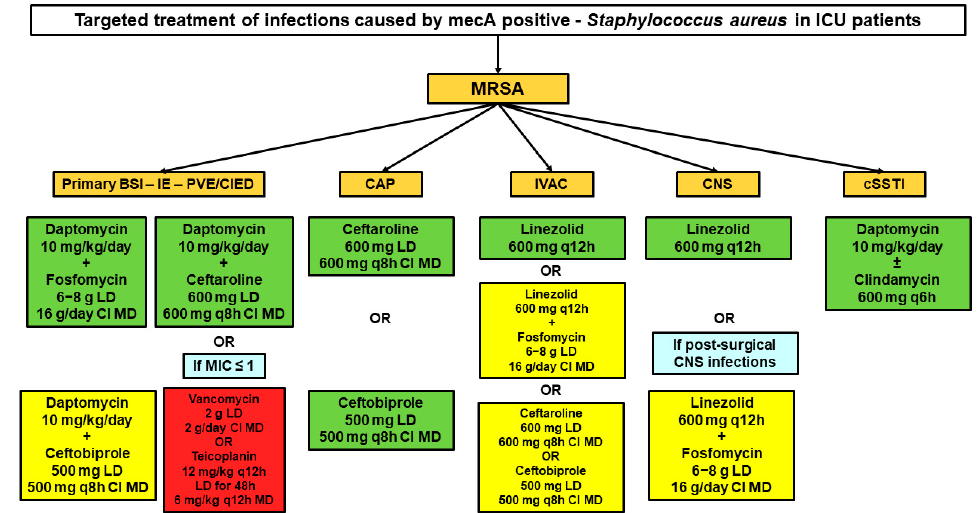
Figure 2. Algorithms for targeted therapy of BSIs or IE caused by methicillin-resistant Staphylococcus aureus . Green box: best therapeutic regimen according to current evidence; yellow box: alternative therapeutic regimen according to current evidence; red box: therapeutic regimen recommended only in specific situations. BSI: bloodstream infection; CAP: community-acquired pneumonia; CI: continuous infusion; CIED: cardiac implantable electronic device infections; CNS: central nervous system; cSSTI: complicated skin and soft tissue infection; ICU: intensive care unit; IE: infective endocarditis; IVAC: infective ventilator-associated complications; LD: loading dose; MD: maintenance dose; PVE: prosthetic valve endocarditis.